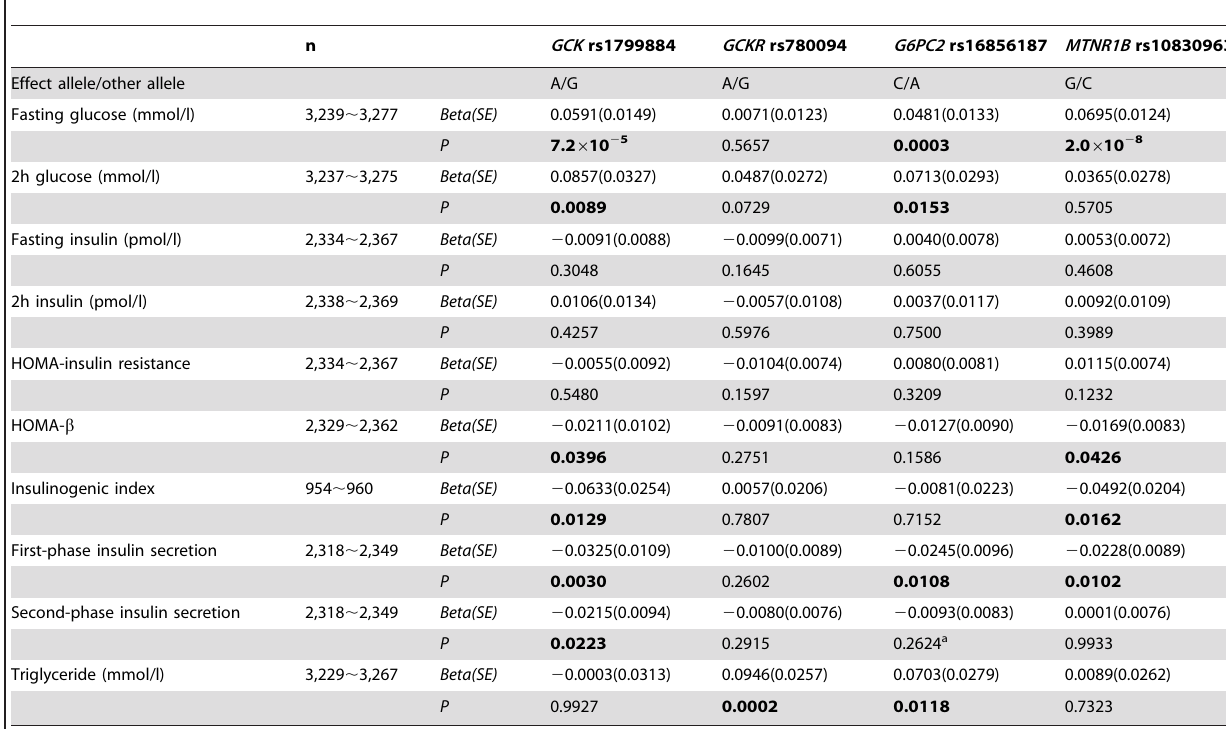
Table 2. Association between GCK , GCKR , G6PC2 and MTNR1B variants and traits related to glucose metabolism.